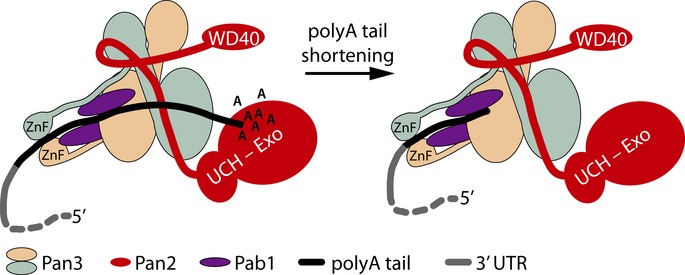
Model for Pan2–Pan3Schematic model for Pan2–Pan3 function, whereby Pan3 channels RNA to the Pan2 exonuclease domain.